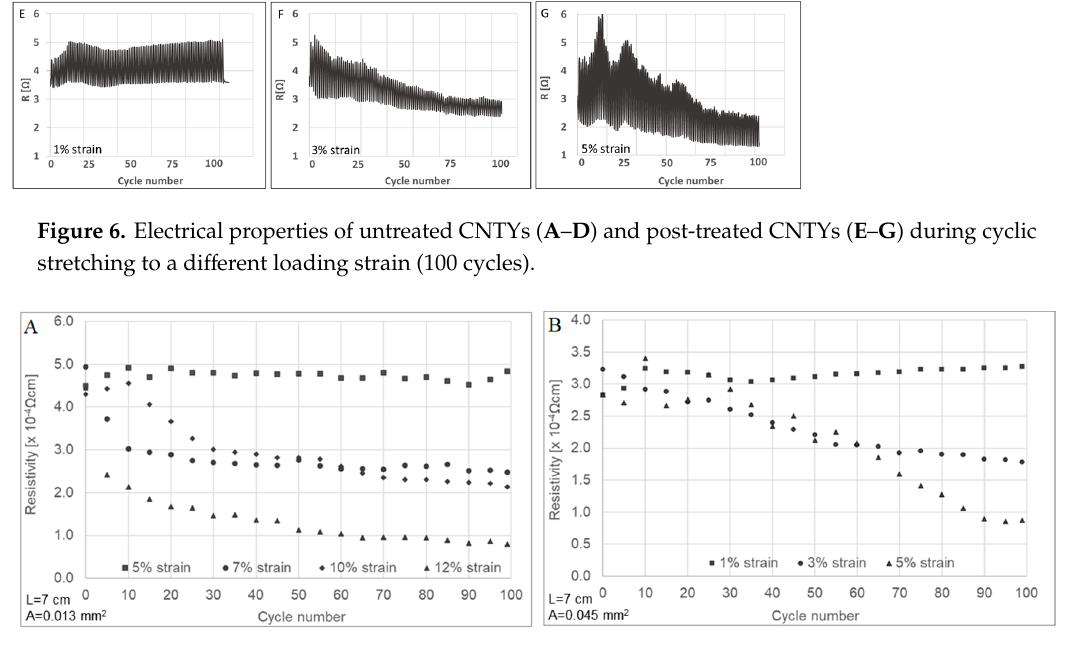
Figure 7. Apparent electrical resistivity of untreated CNTYs ( A ) and post ‐ treated CNTYs ( B ) during cyclic stretching to a different loading strain (100 cycles).